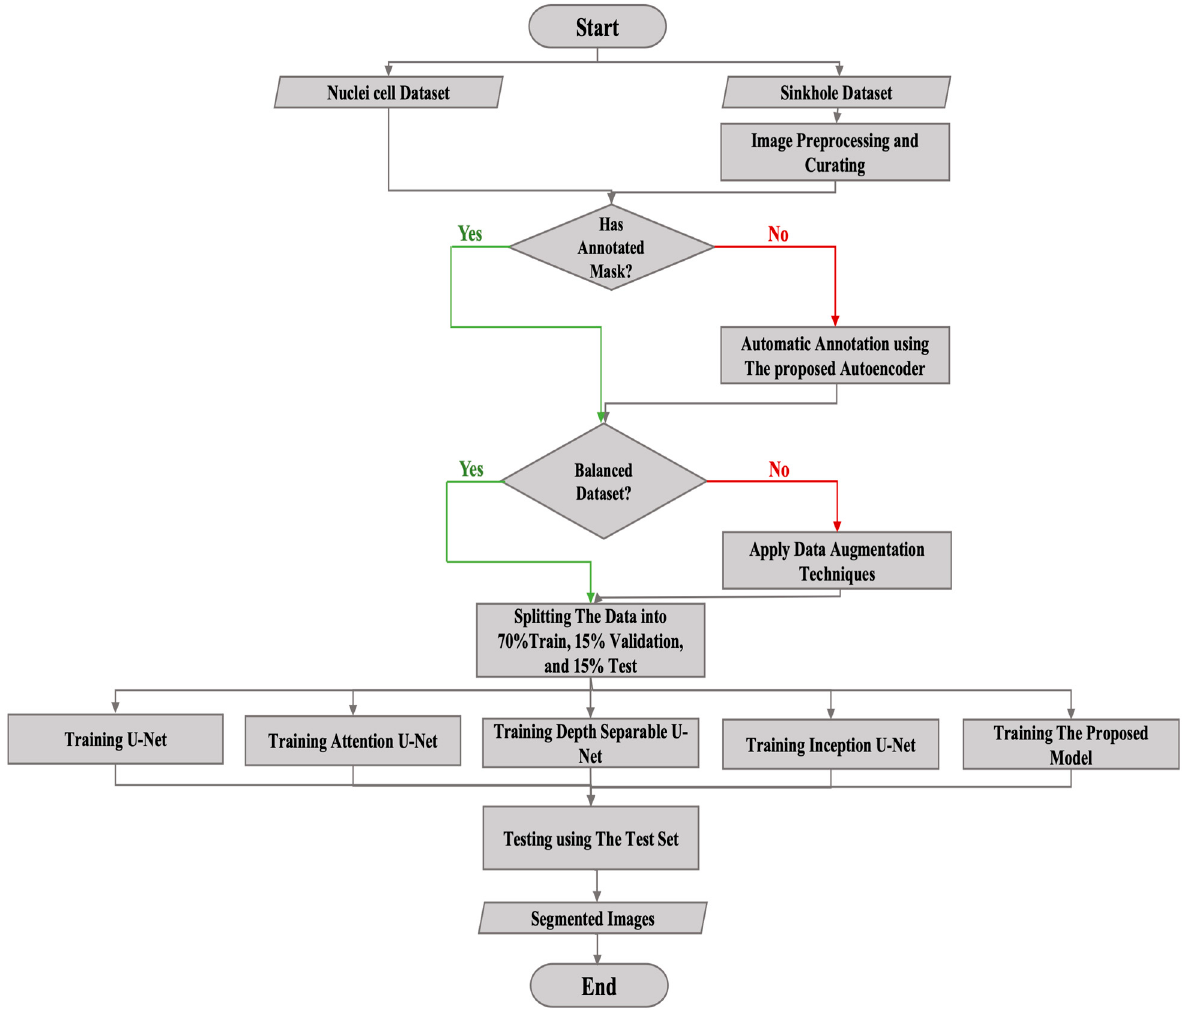
Figure 13. The workflow diagram. After preprocessing and curating the images, the next step is automatically annotating the dataset using the proposed autoencoder, balancing the dataset using data augmentation techniques, and training and evaluating the segmentation models, including the proposed model, using the training and validation sets. The final step is testing the models using the test set.